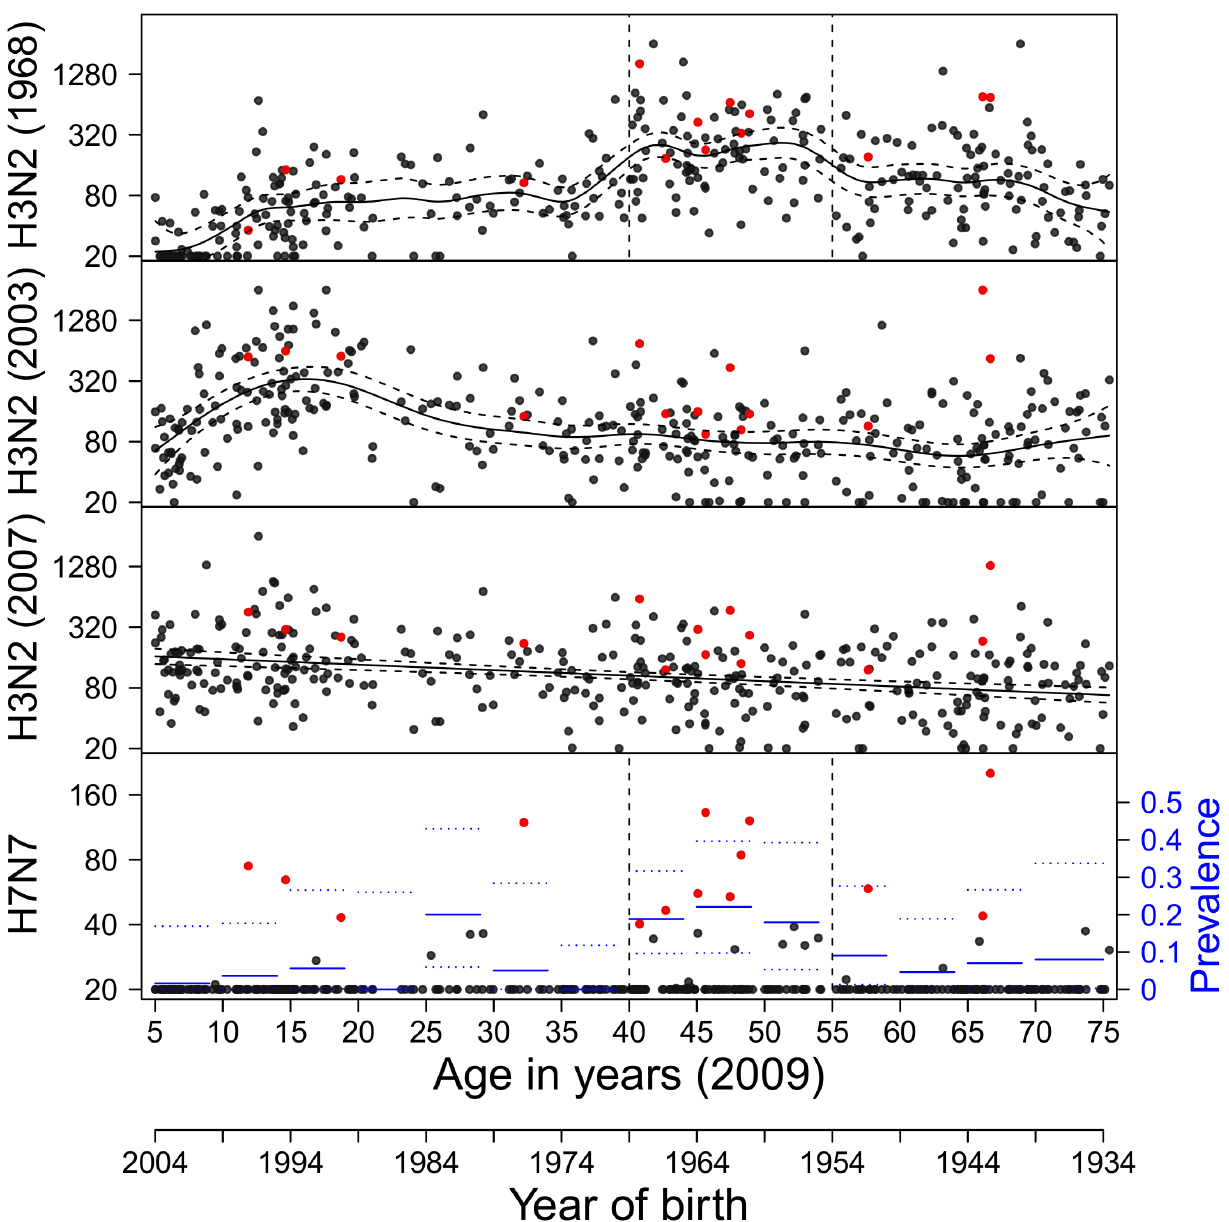
Fig 3. Age-specific antibody titers to group 2 influenza A viruses. Red dots indicate an H7N7titer (cid:21) 40. Seroprevalence to H3N2 viruses reaches 100% in most age strata. Solid and dotted lines show the mean weightedantibody concentrations and associated95% confidence ranges, estimated with a generalizedadditivemodel. For H7N7, solid and dotted lines show interval population-weightedseroprevalence estimates and associated 95% confidencebounds (right axis). Antigens (HA1) includedare from viruses A/Aichi/2/1968 (H3N2), A/Wyoming/ 2003 (H3N2), A/Brisbane/10/2007(H3N2), and